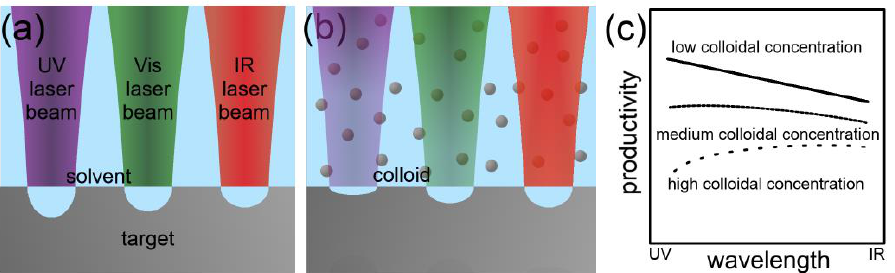
Figure 6. Effect of laser wavelength on the ablation rate in the ( a ) absence and ( b ) presence of colloidal particles, and ( c ) NPs productivity vs. wavelength at different colloidal concentrations. [45].